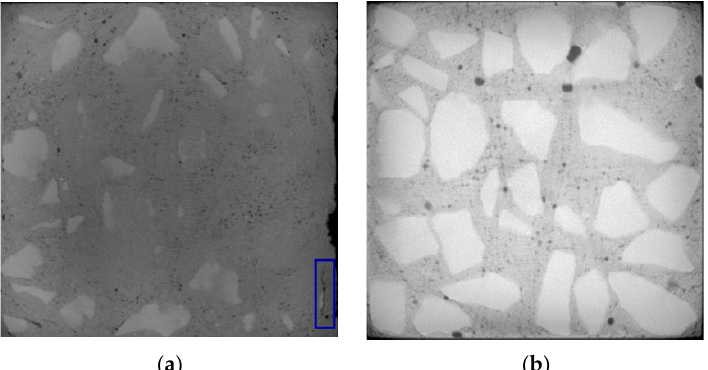
Figure 9. Crack propagation images of D4 under 80 dry–wet cycles of sulfate attack: ( a ) surface layer; ( b ) inner layer.